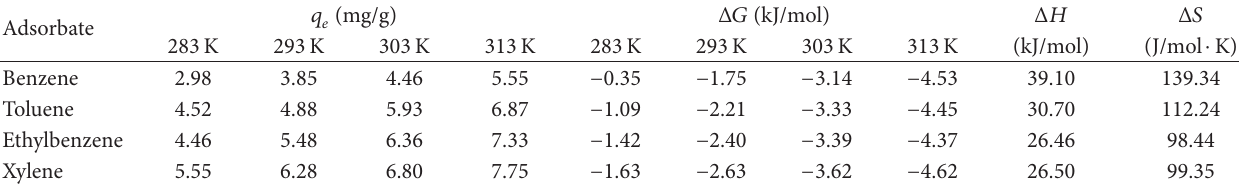
T 5: ermodynamic parameters for removal of BTEX by TTAB-Mt.